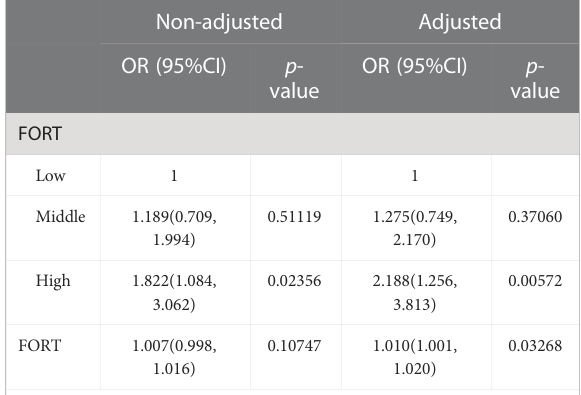
TABLE 4 Follicular output rate and cumulative live birth